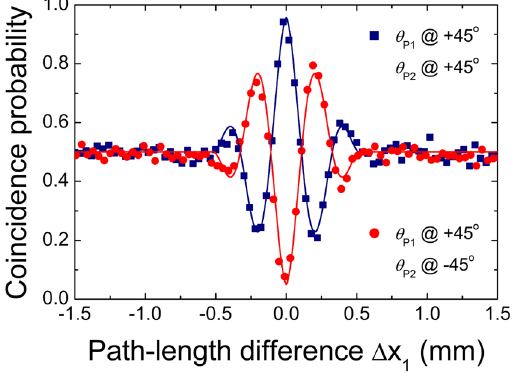
Figure 3. Measured HOM peak and dip fringes as a function of Δ x 1 for nondegenerate photon pairs when Δ x = 0